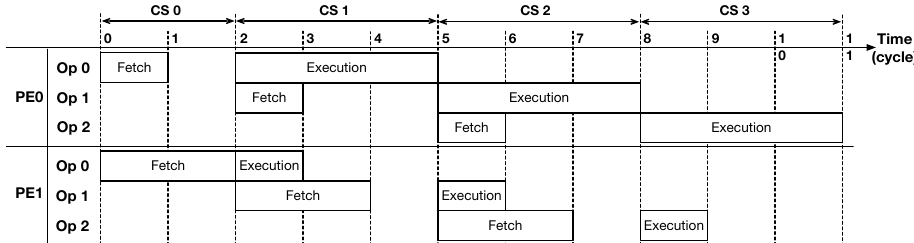
Figure 3. Pipeline and synchronization example. CS is the control step; within each control step, each PE can perform at most one operation or fetch at most one new